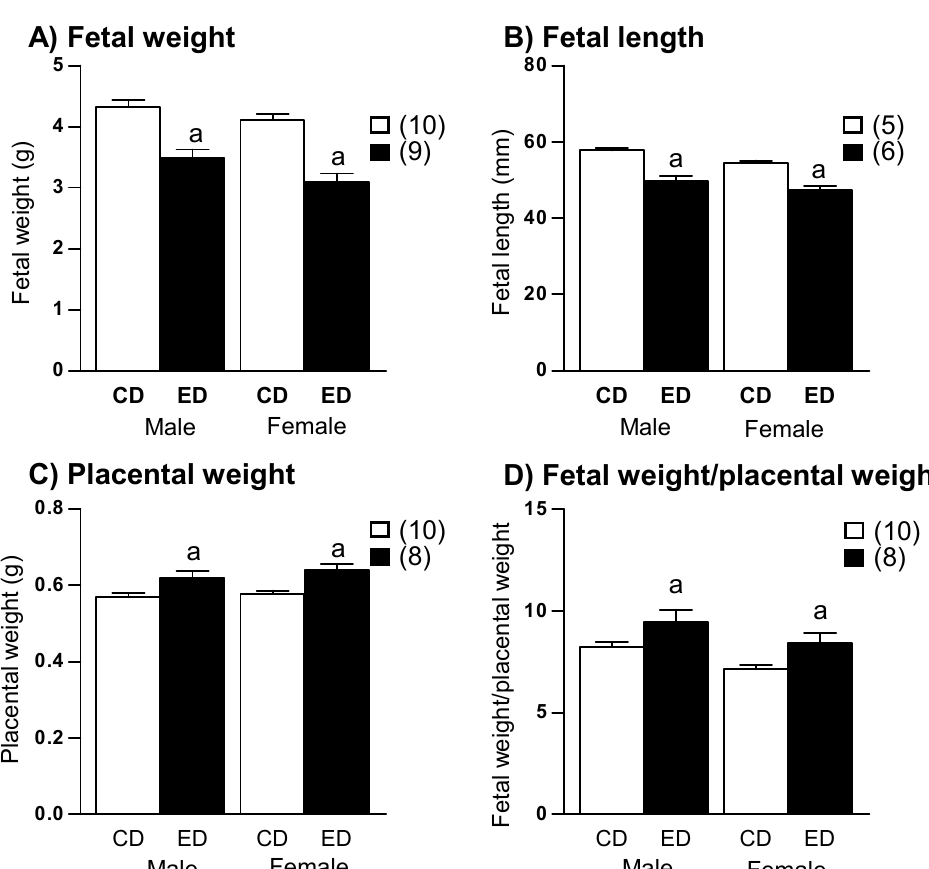
Figure 3. ( A ) Fetal body weight, ( B ) fetal body length, ( C ) placental weight, and ( D ) fetal weight/placental weight in control (CD) and experimental diet (ED) fed groups. Data show mean ± SEM. Between parenthesis, the litter sample size is shown (from each litter 5–6 fetuses of each sex were averaged). Student’s t test. a p < 0.01 ED versus CD.